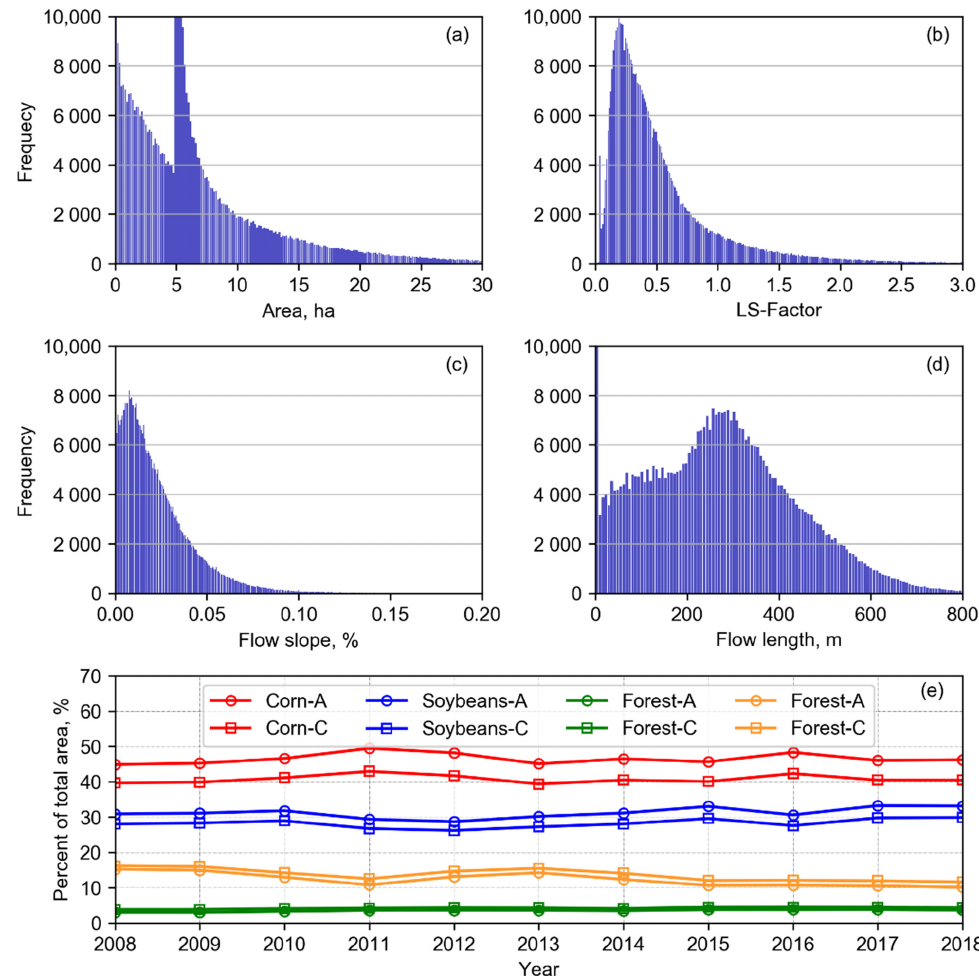
Figure 8. Histograms of topographic characteristics of the 469,628 AnnAGNPS cells considered in the integrated hydrological simulation, for area ( a ), RUSLE LS-factor ( b ), flow slope ( c ), and flow length ( d ). Comparison between crop type determined from the CDL raster grid and discretized AnnAGNPS cells ( e ).